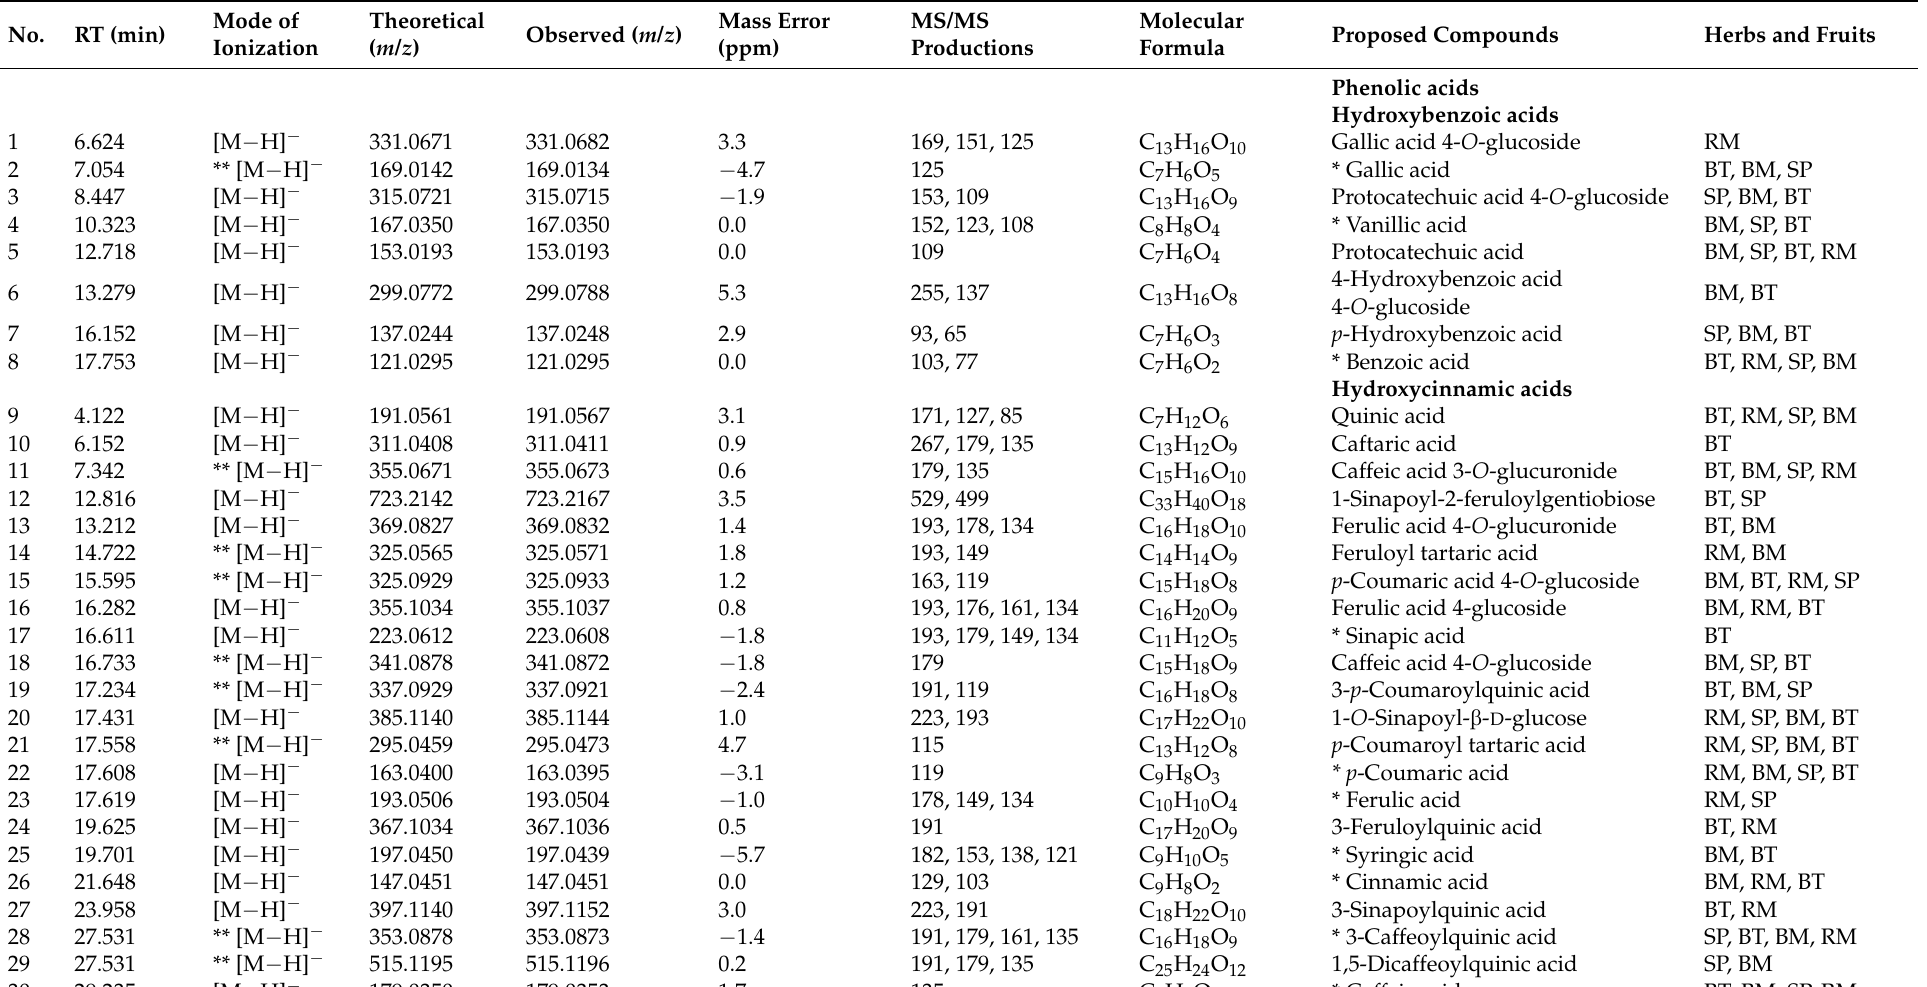
Table 2. LC-MS/MS characterization of phenolic metabolites from Australian native herbs and